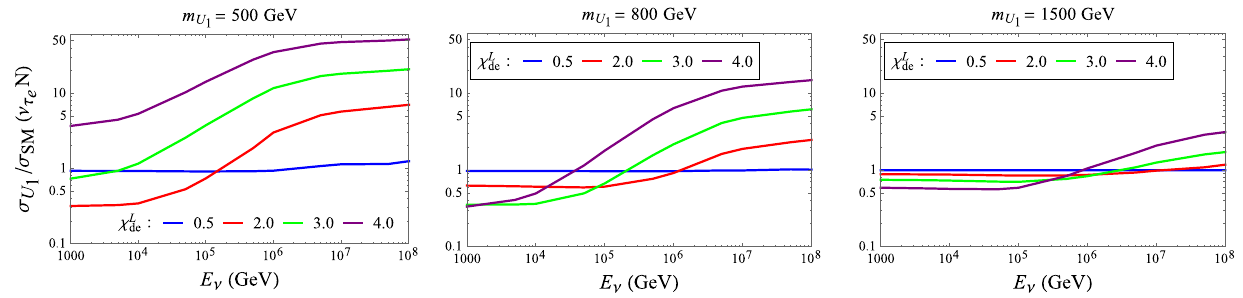
Fig. 5 The ratio of ν e N total cross sections between the SM + U 1 and the SM for different masses and couplings of U 1